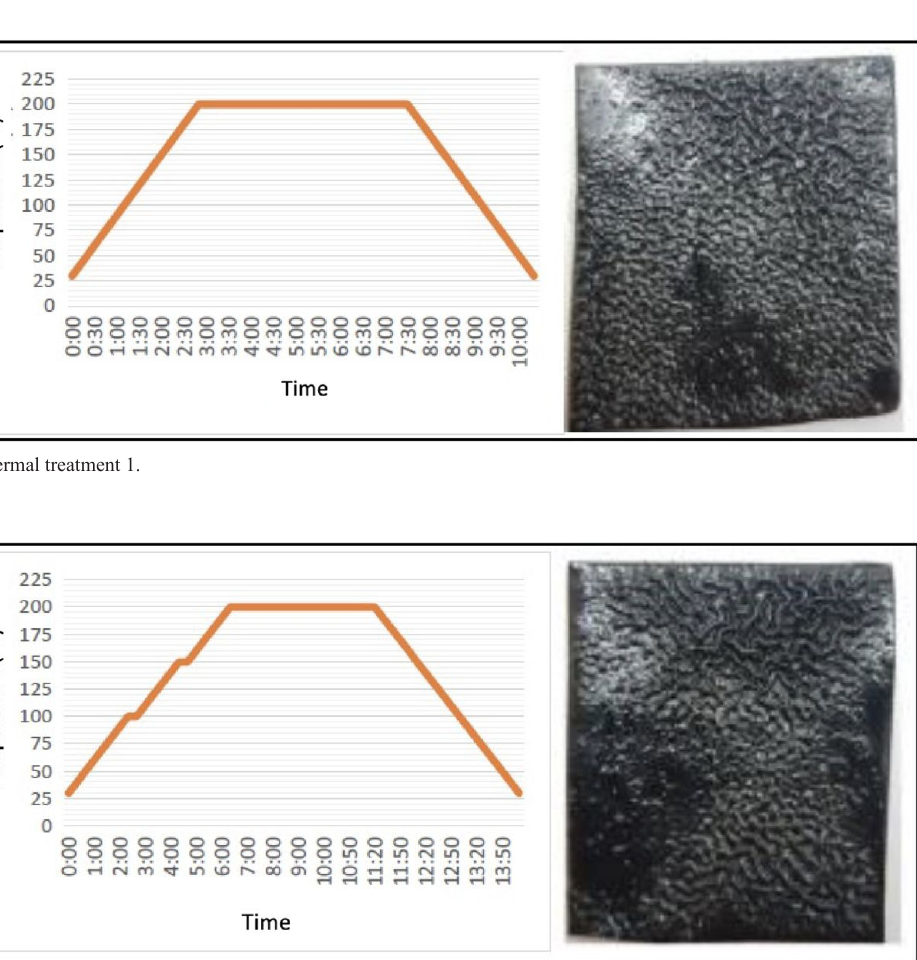
Figure 6. Thermal treatment